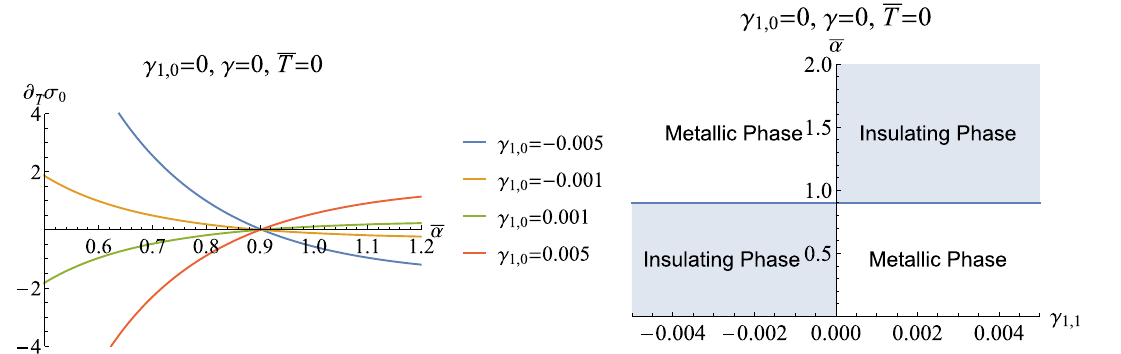
σ ¯ α at zero temperature. Right plot: Phase diagram over (γ Fig. 8 Left plot: ∂ ¯ 0 as a function of T at zero